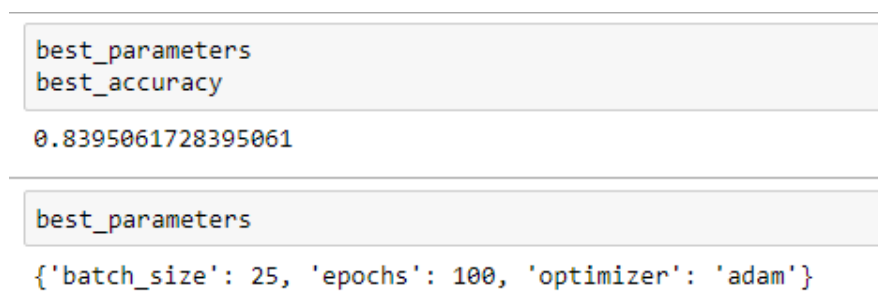
Figure 38. The best parameters with obtained after performing grid search with 5-Fold Cross-Validation on the ANN (3-20-20-1) model.